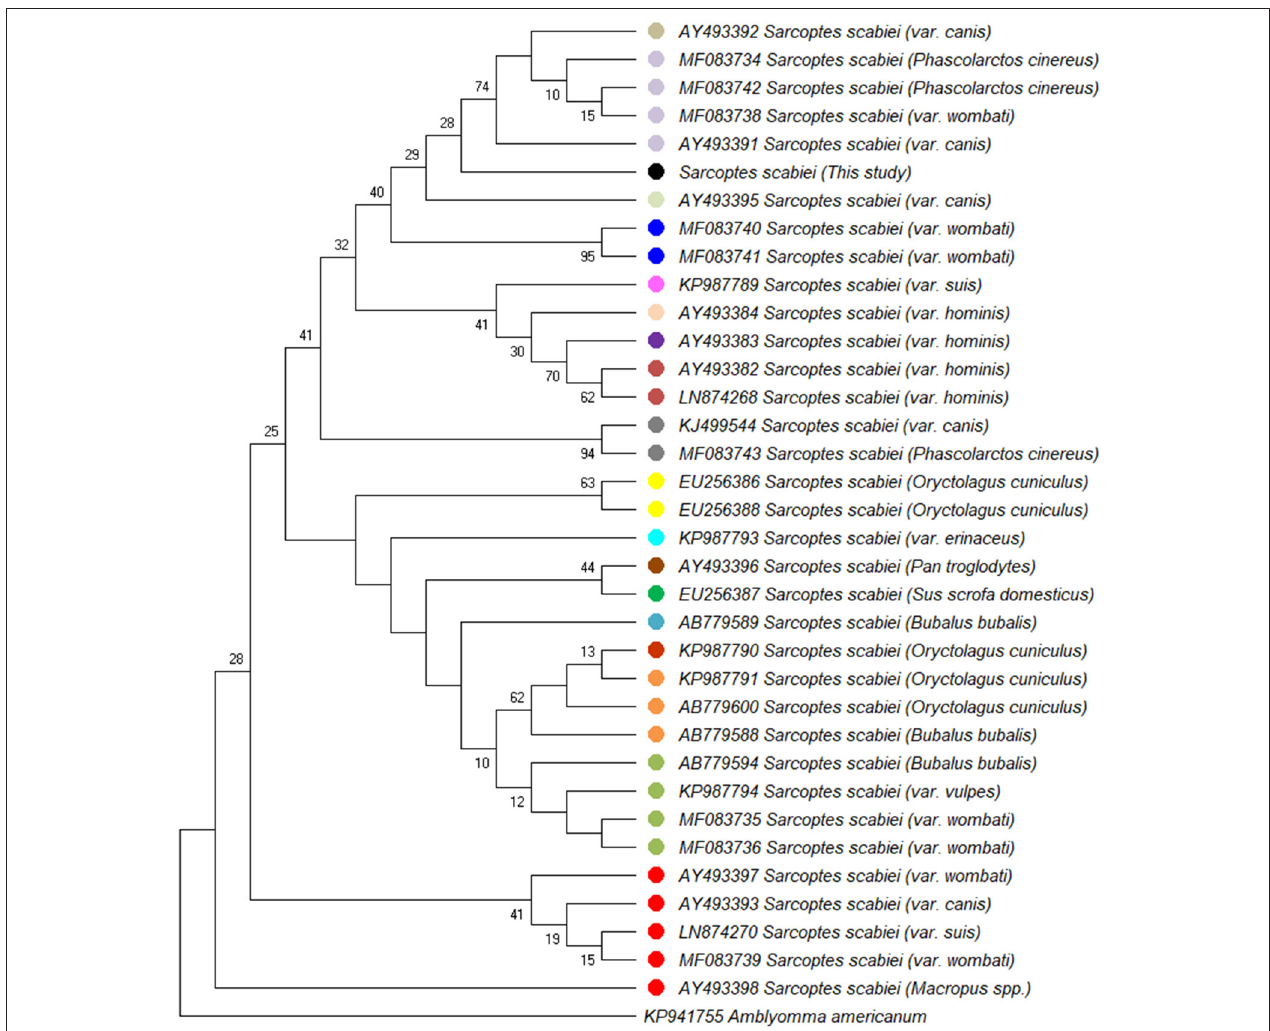
FIGURE 3 | Maximum likelihood phylogenetic analysis of 36 partial mt-cox1 sequences analyzing 682 basepairs in each sequence using the HKY85 + I method. The percentage of trees in which the associated taxa clustered together is shown next to the branches. The sequence from the present study is indicated ( · ). Sequences obtained from GenBank records are indicated by accession